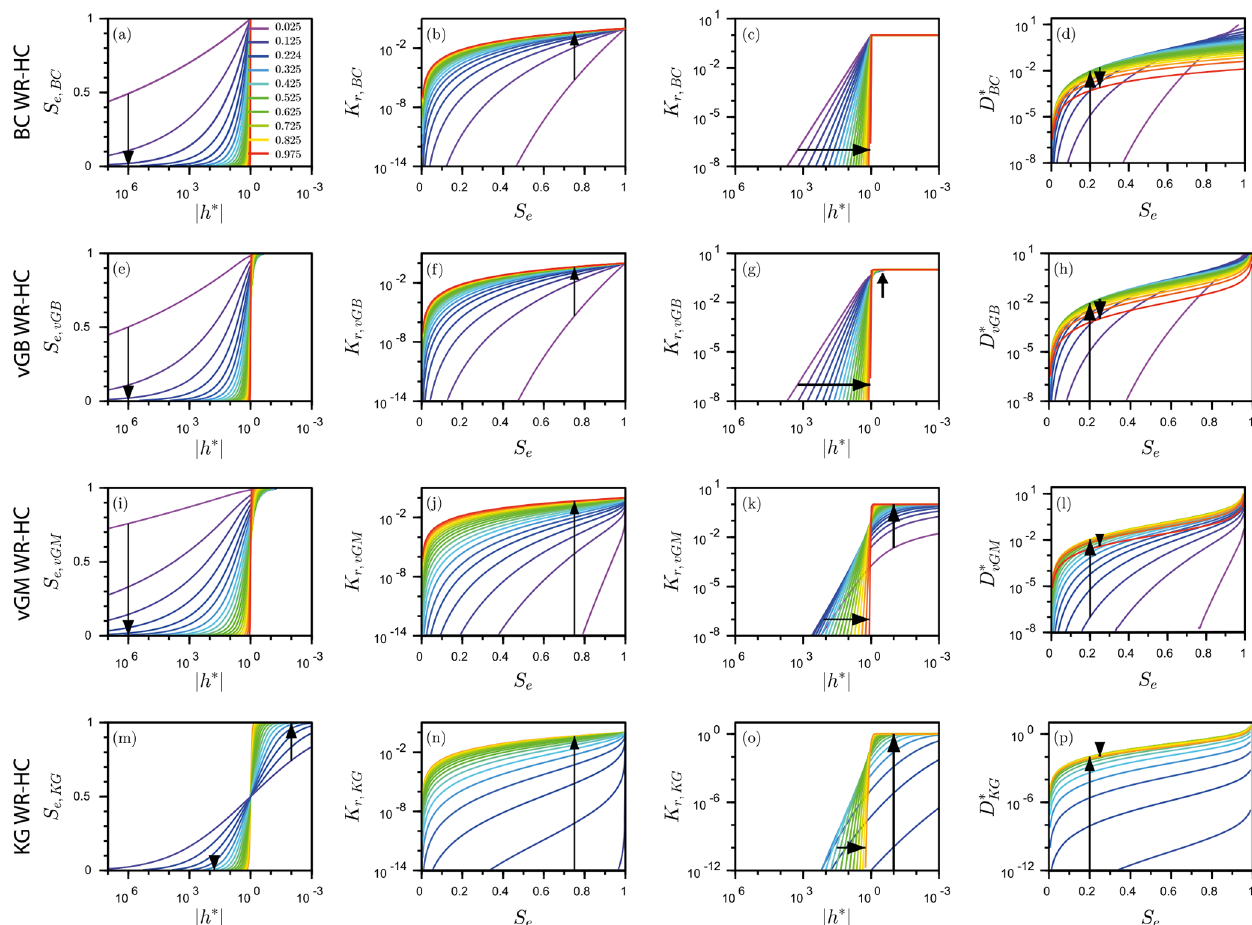
Figure 4. Water retention (WR) and hydraulic conductivity (HC) curves for different values of the WR shape index x . Panels (a, e, i, m) show WR as S e (h ∗ ) , panels (b, f, j, n) show HC as K r (S e ) , panels (c, g, k, o) show HC as K r (h ∗ ) , and panels (d, h, l, p) show diffusivity as D ∗ (S e ) ; the four tested models include Brooks and Corey (BC) (a–d) , van Genuchten–Burdine (vGB) (e–h) , van Genuchten– Mualem (vGM) (i–l) , and Kosugi (KG) models (m–p) . The arrows indicate the trends with increasing WR shape index x . The hydraulic parameters λ BC , m vGM , m vGB , and σ KG were computed as a function of x using Eq. (36) with l vGM = l KG = 1 et al.